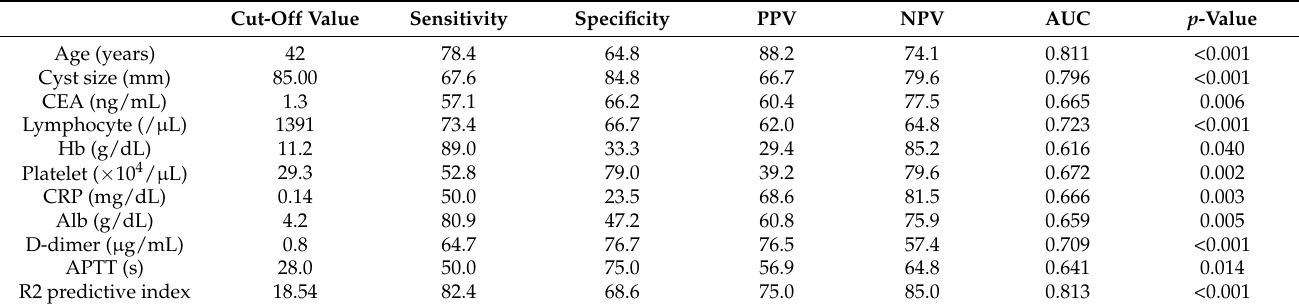
Table 3. Cut-off values discriminating EAOC from benign OE in the validation cohort. Cut-Off Value